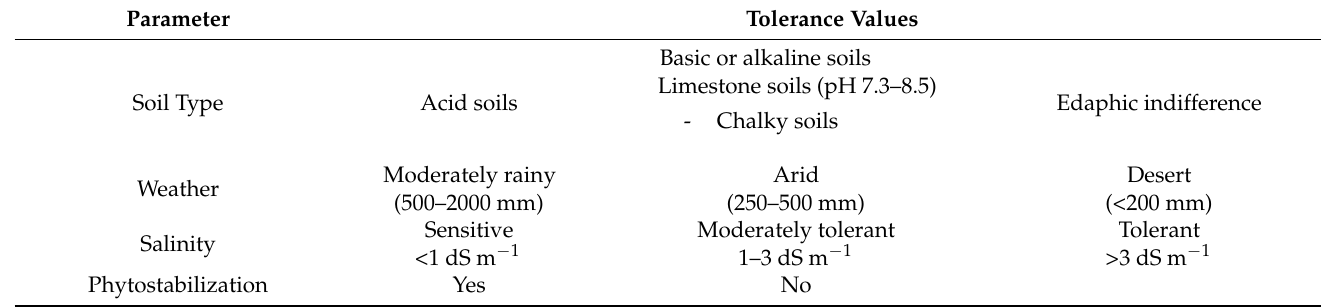
Table 1. Parameters to consider for the choice of species based on tolerance values [35]. Parameter Tolerance